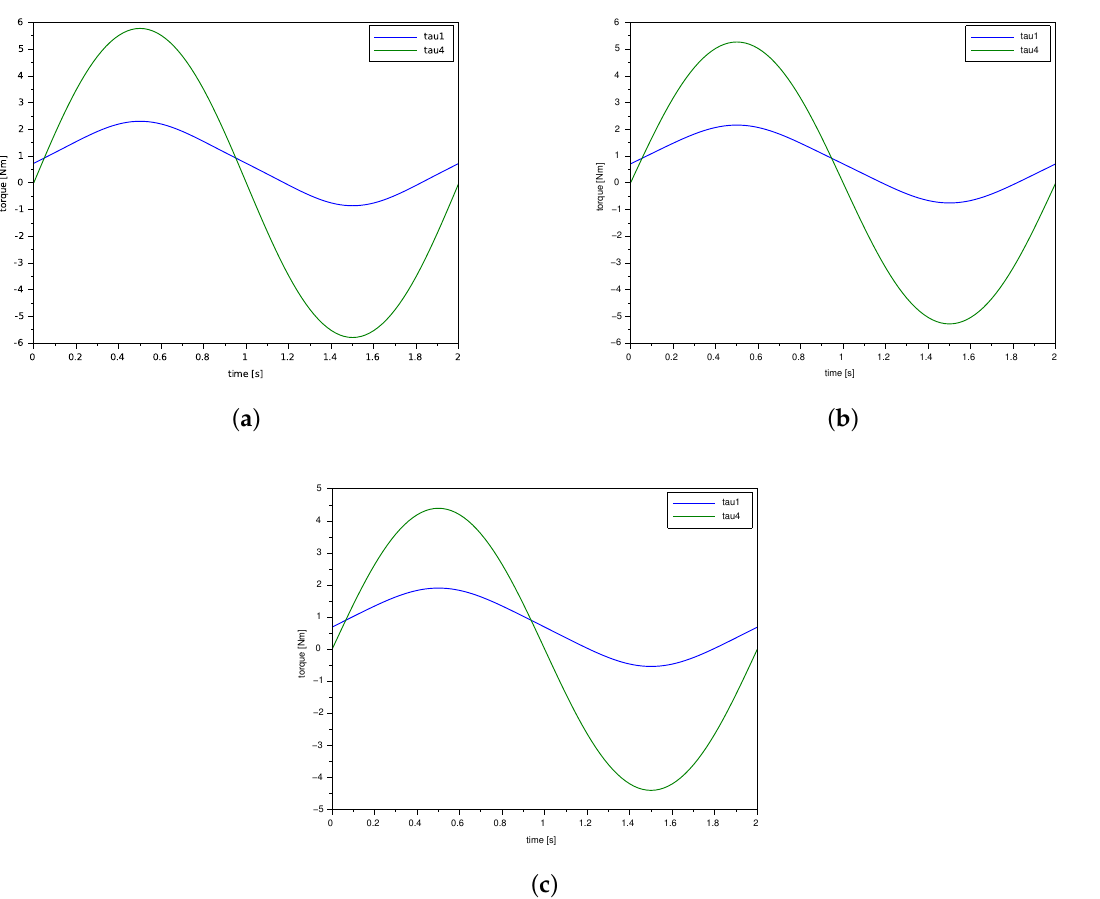
Figure 6. Inverse dynamics: torques of actuators 1 ( τ 1 : tau1) and 4 ( τ 4 : tau4) simulated for subjects of different heights and weights: ( a ) 1.8 m and 80 kg; ( b ) 1.7 m and 60 kg; ( c ) 1.6 m and 50